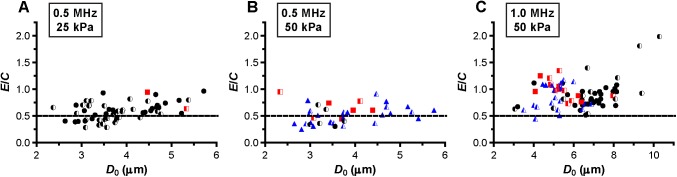
E/C.For microbubbles insonified at a frequency of 0.5 MHz and P_ of 25 kPa (A), frequency of 0.5 MHz and P_ of 50 kPa (B), and frequency of 1 MHz and P_ of 50 kPa (C). For figure legend, see the rightmost column of Fig 2 and Fig 3. Microbubbles with an E/C < 0.5 show compression-only behavior, indicated by the dashed line.